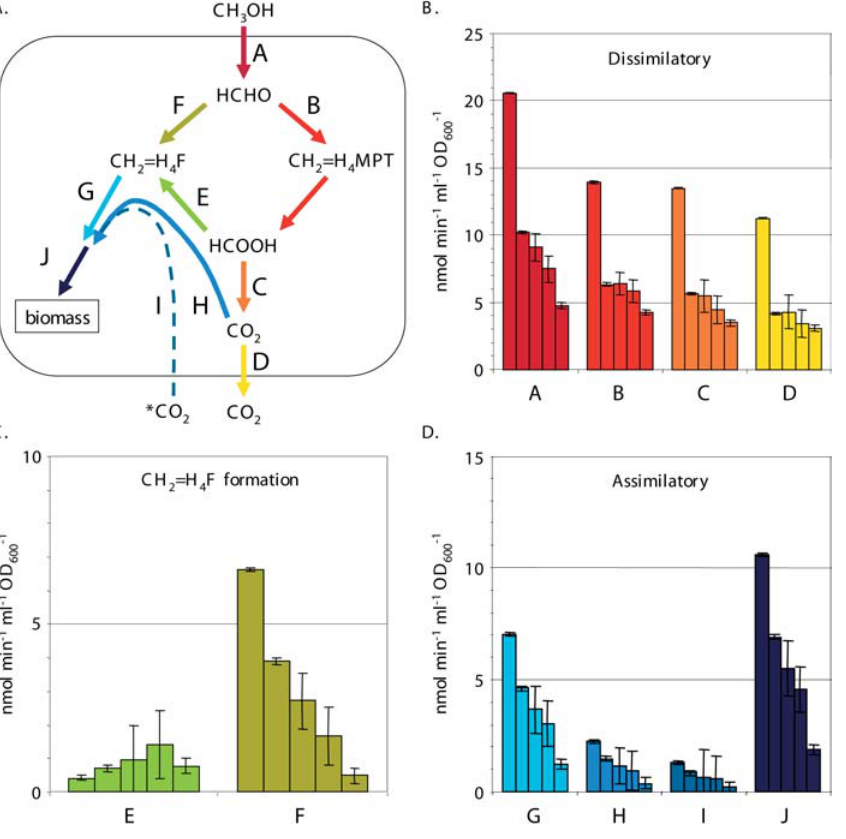
Figure 5. C 1 Fluxes during Transition from Methanol to Succinate The fluxes determined are represented schematically (A). The other panels present flux for each branch, labeled A through J. The five bars for each flux represent a time series from cells harvested 1 h prior to the transition from methanol to succinate, and 1, 3, 5, and 7 h after the switch. Dissimilatory (B), methylene-H 4 F formation (C), and assimilatory (D) fluxes are presented separately with different scales for clarity. Flux F represents maximum fluxes. DOI: 10.1371/journal.pbio.0030016.g005